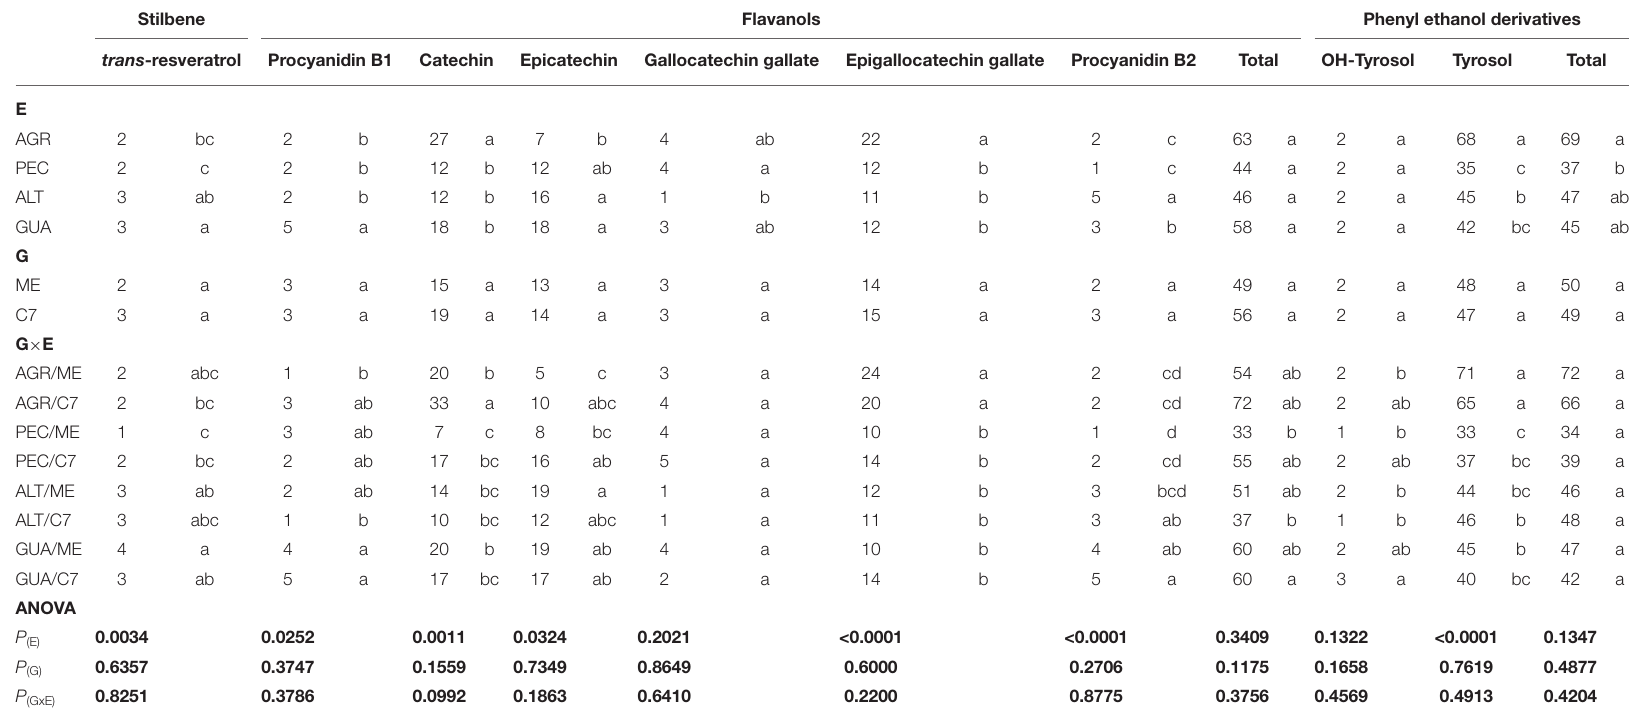
TABLE 4 | Levels of non-anthocyanin PCs in wines of Cabernet Sauvignon Clone 7 (C7) and Mount Eden (ME) from four vineyards (AGR, PEC, ALT and GUA). Stilbene Flavanols trans